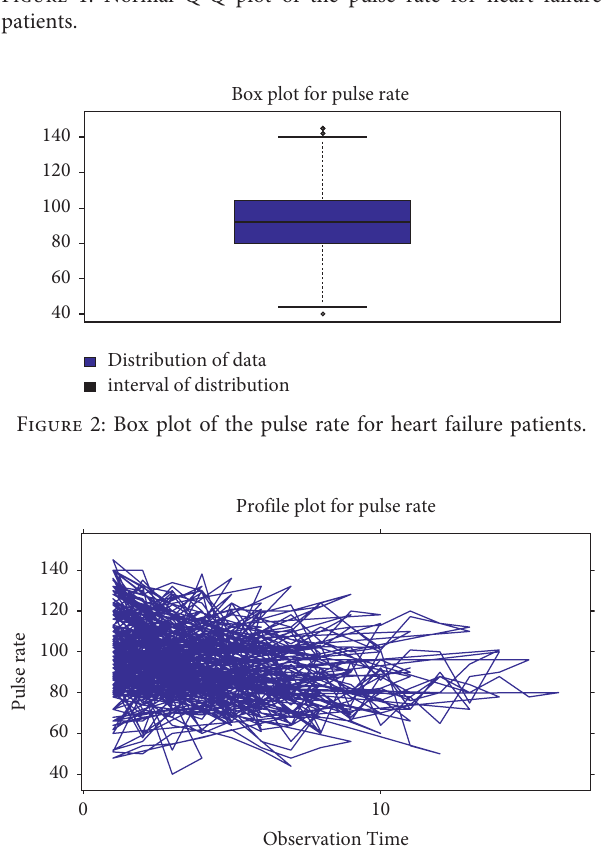
Figure 3: Profile plot of the pulse rate for heart failure patients.